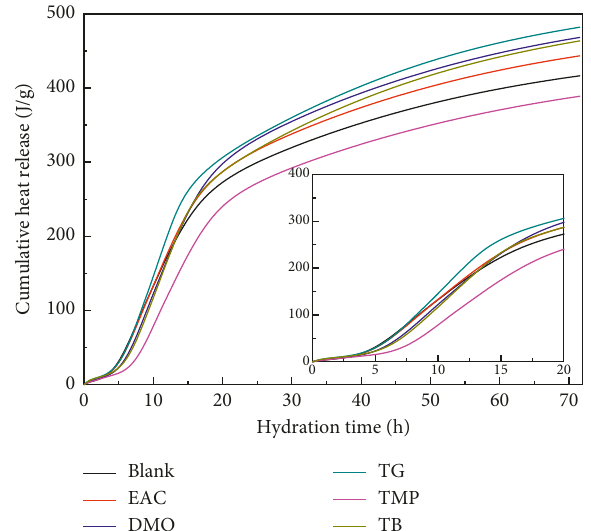
Figure 2: Effect of ester on the total heat release of cement hydration.